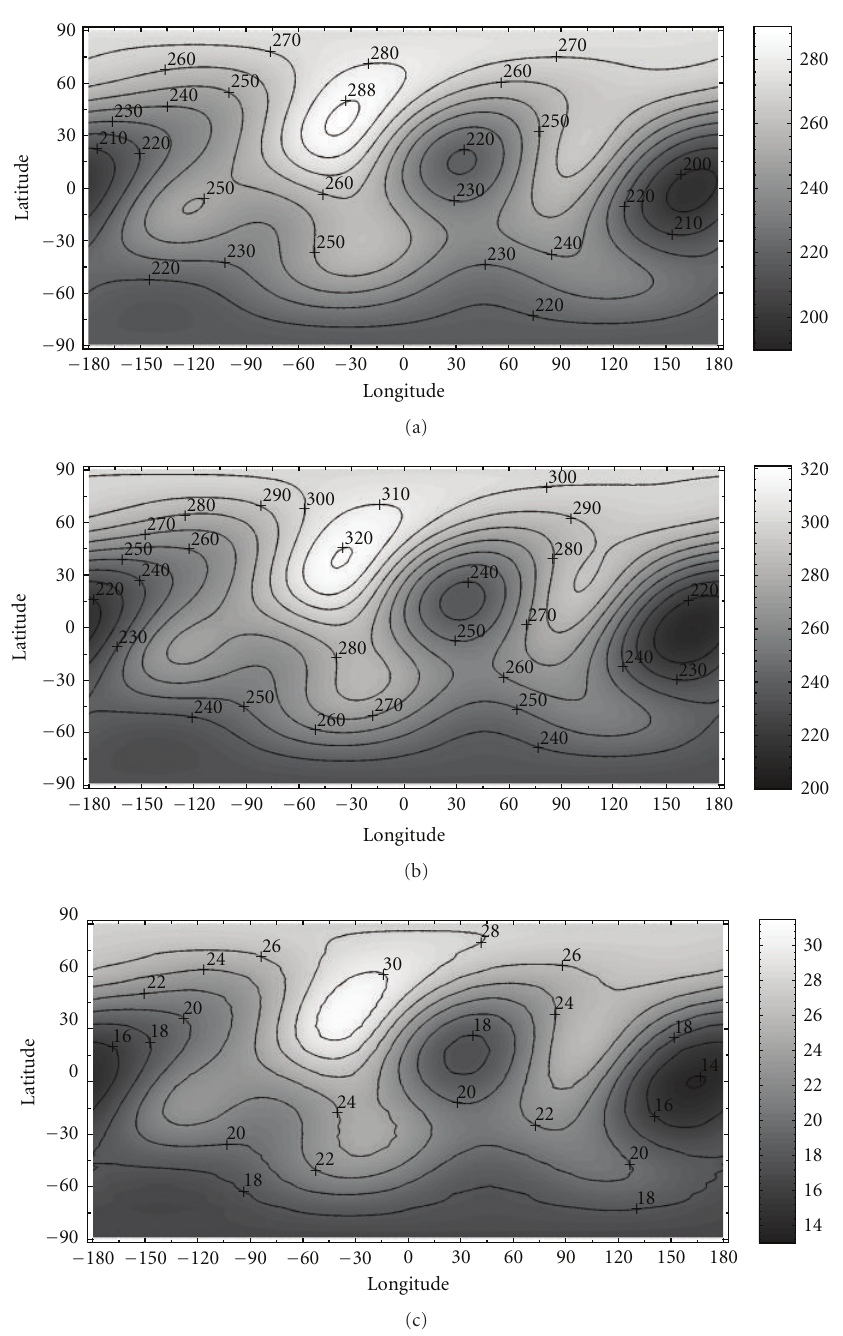
Figure 8: The global distributions of the atmospheric temperature (K) at 110km altitude, obtained from the NRLMSISE-00 empirical model for 16 July, UT = 10 . 30 and calculated for two distinct values of solar activity: F 10 . 7 = 101 (a) and F 10 . 7 = 230 (b). Also the di ff erence between the latter and the former distributions